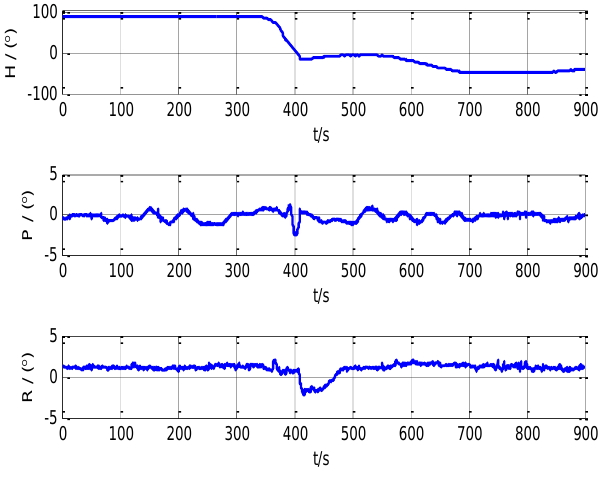
Figure 4. The attitude curve of M-SINS.